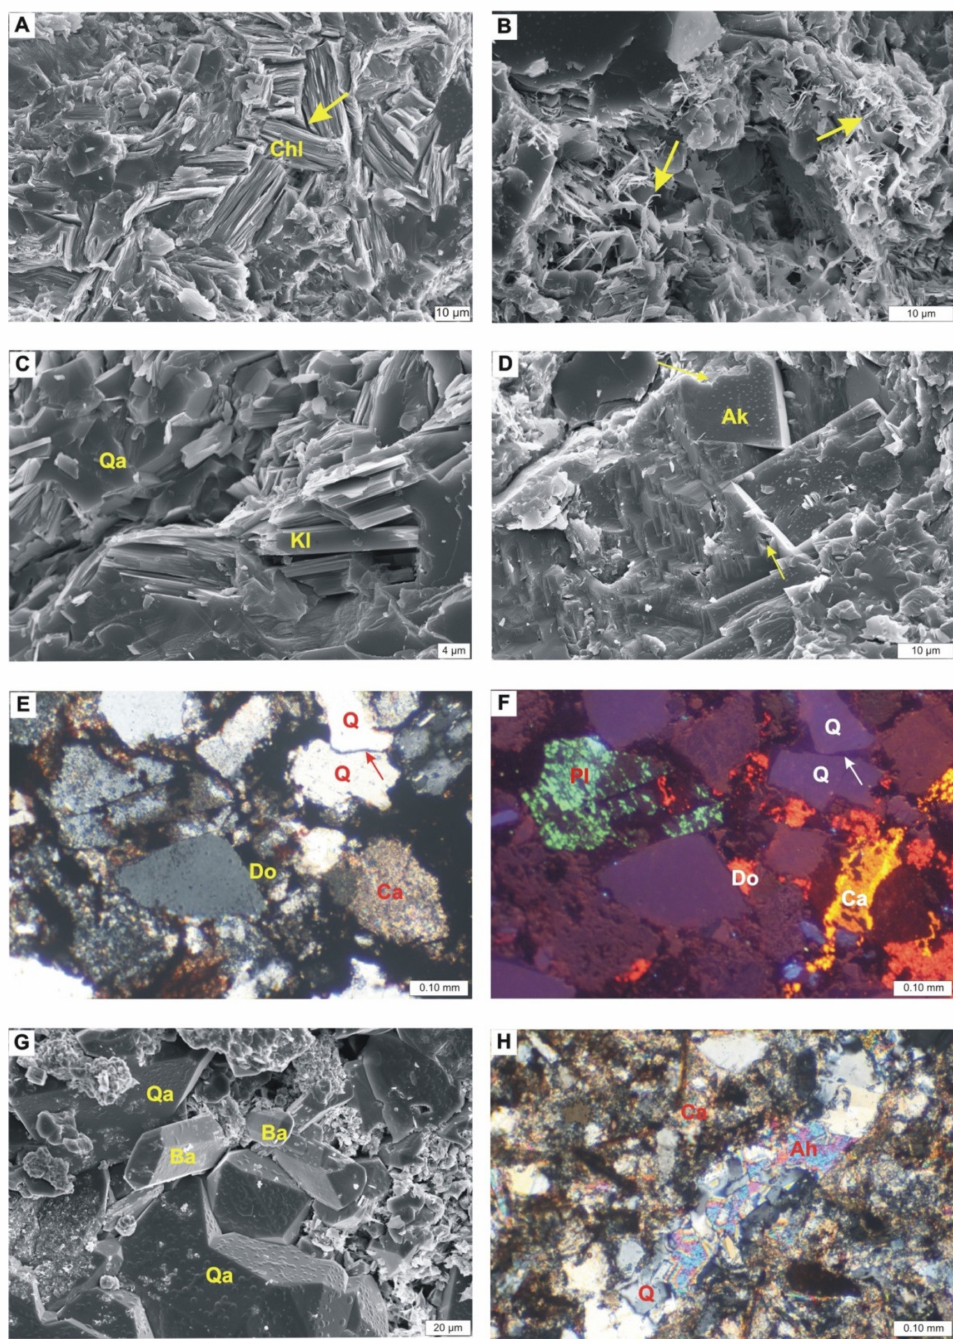
Figure 3. Photomicrographs of sandstones from a polarizing microscope (PL), cathodoluminesence (CL) and a scanning electron microscope (SEI). ( A ) Flakes of authigenic chlorite (Chl); distinct microporosity (arrow); Kalisz IG 1 borehole, depth of 3584.7 m, SEI image. ( B ) Fibrous illite in the pore space of volcanoclstic, lithic wacke; Katarzynin 2, depth of 2640.0 m, SEI image. ( C) Authigenic kaolinite (Kl) with authigenic quartz (Qa) in subarkosic wackes; Objezierze IG 1 borehole; depth of 4964.8 m, SEI image. ( D ) Rhombohedra of ankerite (Ak); ankerite dissolution (arrows); SEI image; Kalisz IG 1 borehole, depth 3423.1 m. ( E ) A fragment of sublithic arenite-quartz (Q), plagioclase (Pl), cements: quartz (arrow) and carbonates: calcite (Ca) and dolomite (Do); Zakrzyn IG 1 borehole, depth of 4584.5 m; PL-crossed polars. ( F ) A CL image of the rock from Figure A; plagioclase (Pl) of blue-green luminescence, partly albitized (black-brown) and replaced by dolomite (red color),